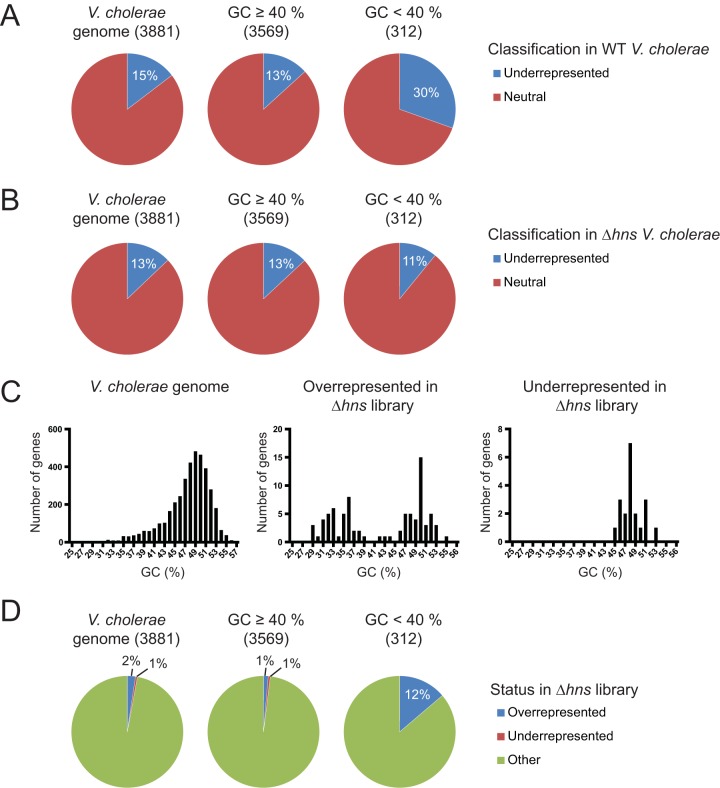
The skew in underrepresented transposon insertions in low-GC-content V. cholerae genes is not observed in the absence of H-NS. (A) Pie graphs depicting the relative frequencies of V. cholerae genes from reference 22, now classified as underrepresented or neutral. Frequencies are depicted for all classified genes and for the subsets of these genes with GC content of ≥40% and <40%. (B) Pie graphs depicting the relative frequencies of underrepresented and neutral loci among all genes categorized in the Δhns library and for the subsets of these genes with GC content of ≥40% and <40%. (C) Histograms of GC content for all V. cholerae protein coding sequences, underrepresented genes in the Δhns library, and overrepresented genes. (D) Pie graphs showing the relative frequencies of genes that are overrepresented or underrepresented in the Δhns library relative to all V. cholerae open reading frames that could be classified and to the subsets of the genes with GC content of ≥40% and <40%.